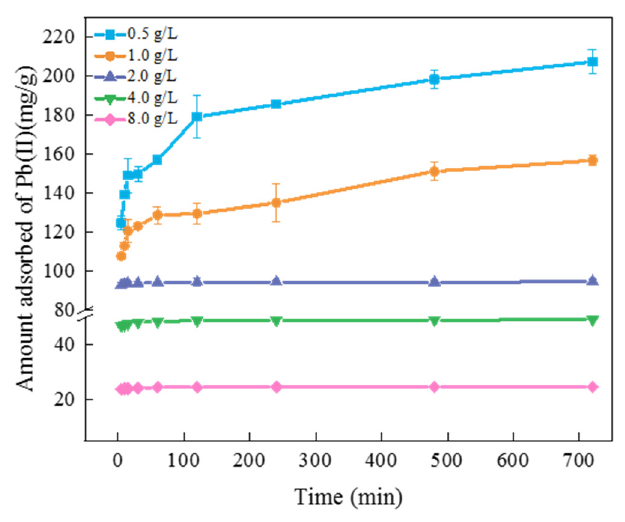
Figure 5. The effect of FM-BC addition on Pb(II) adsorption by FM-BC.